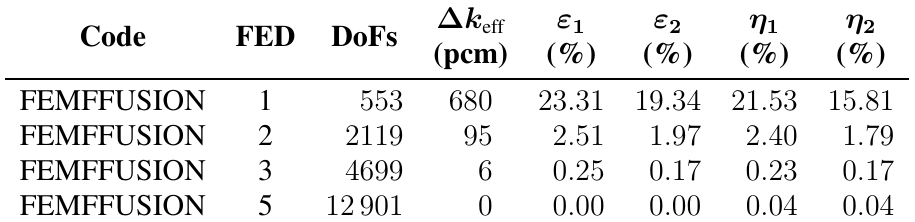
Table 2: Convergence table for 2D IAEA